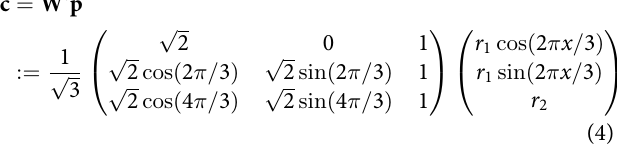
FIGURE 4 | The 3D cone formed by evidence ^ r 222 , coherence ^ r 111 = ^ r 222 , and value ^ x . context is dependent on the transformation group